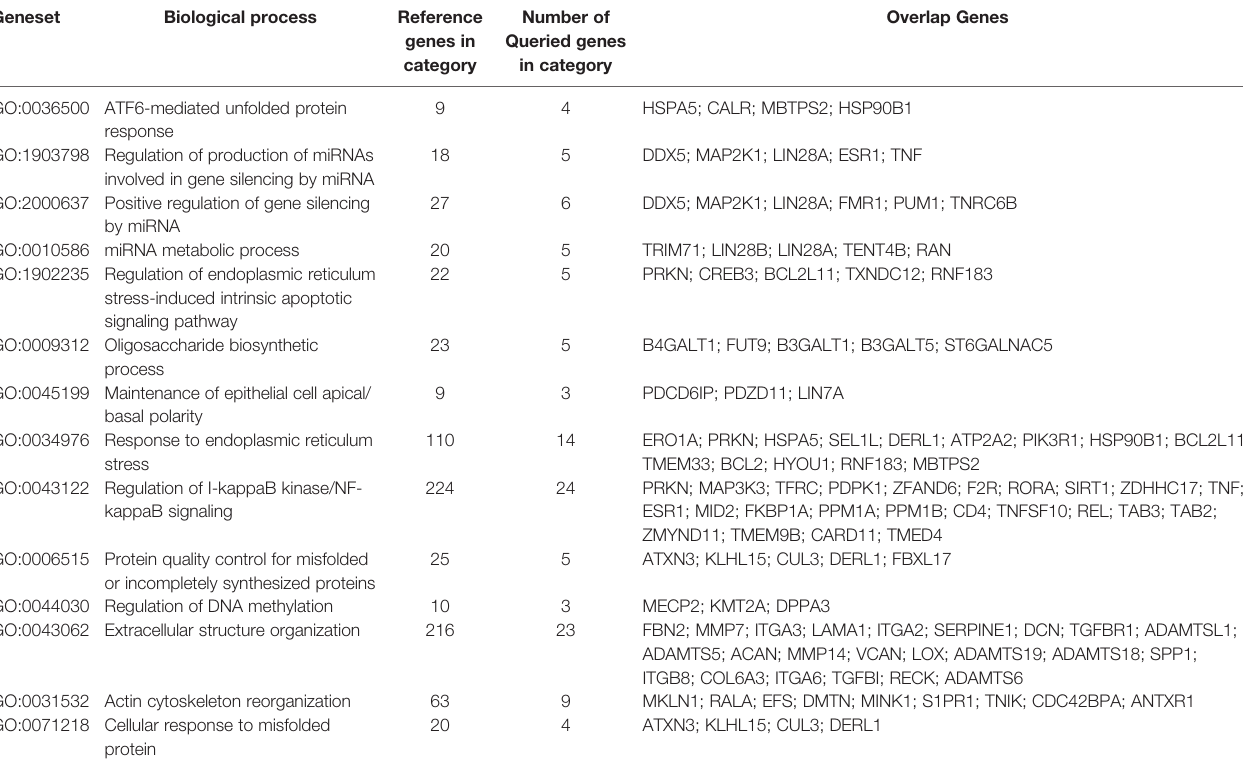
TABLE 3 | Gene Ontology (GO) analysis of biological processes associated with hsa-miR-181d-5p.